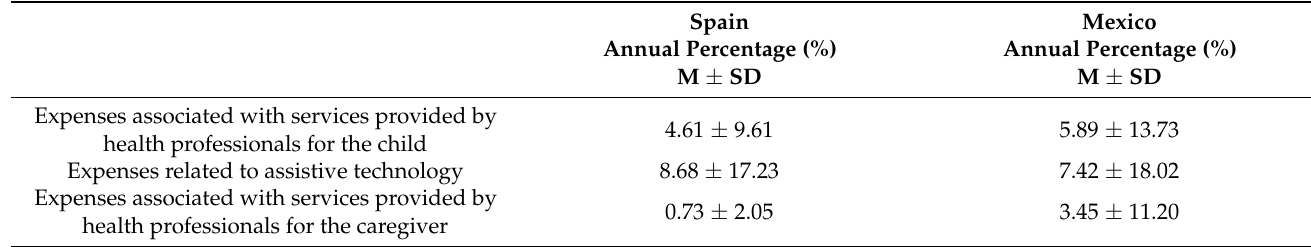
Table 2. Percentage of annual income related to caregivers’ health expenses ( n =